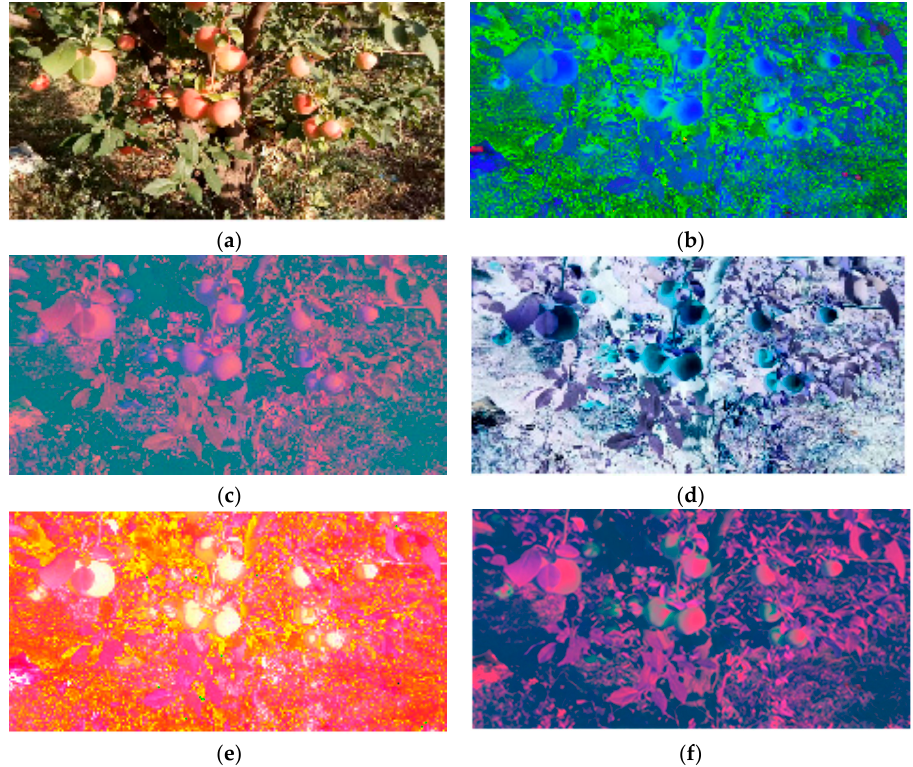
Figure 4. Sample apple tree image under six different color spaces. ( a ) RGB color space. ( b ) HSV color space. ( c ) YCbCr color space. ( d ) CMY color space. ( e ) HSL color space. ( f ) L*u*v* color space. For